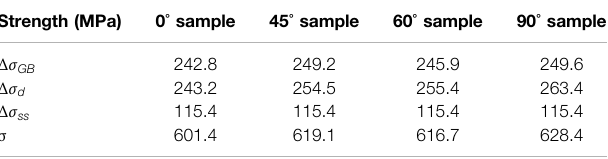
TABLE 3 | Contribution of each strengthening mechanism on the yield strength of the SLM-fabricated 316L SS with different angles relative to the build substrate based on the